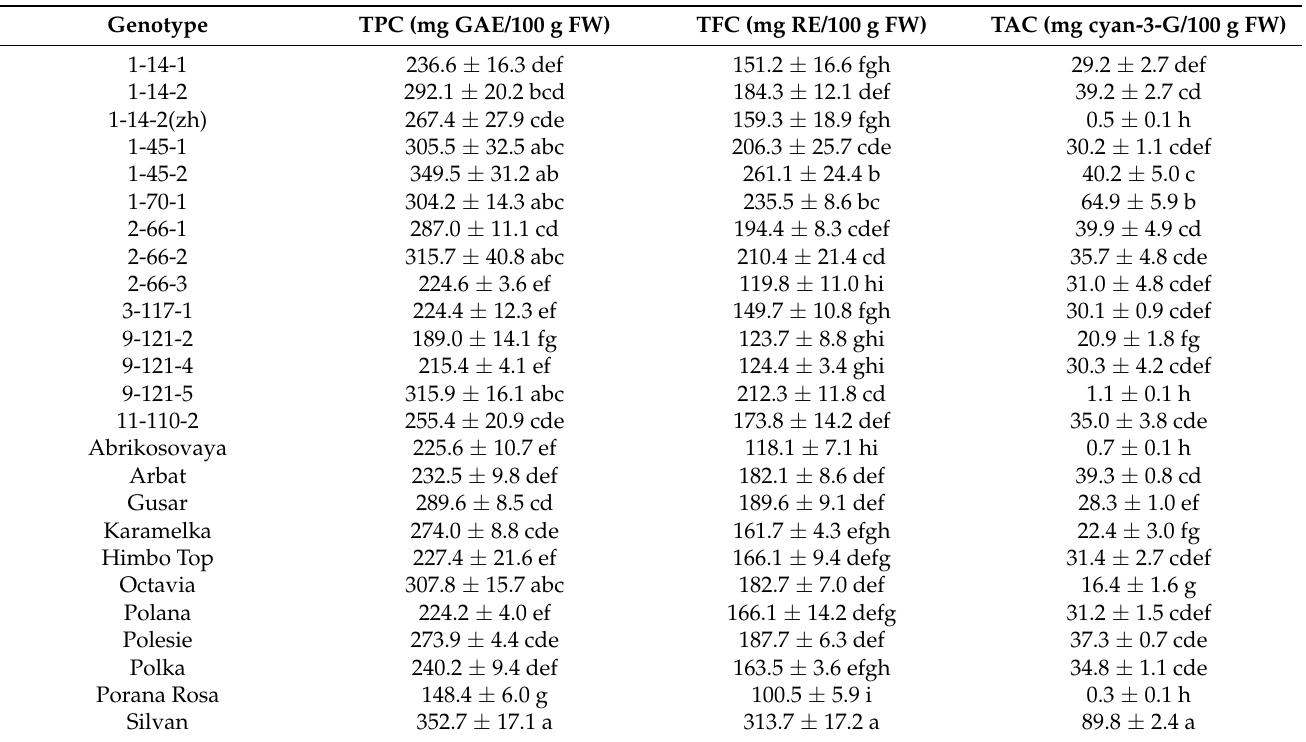
Table 2. Content of phenolic compounds in berries of raspberry